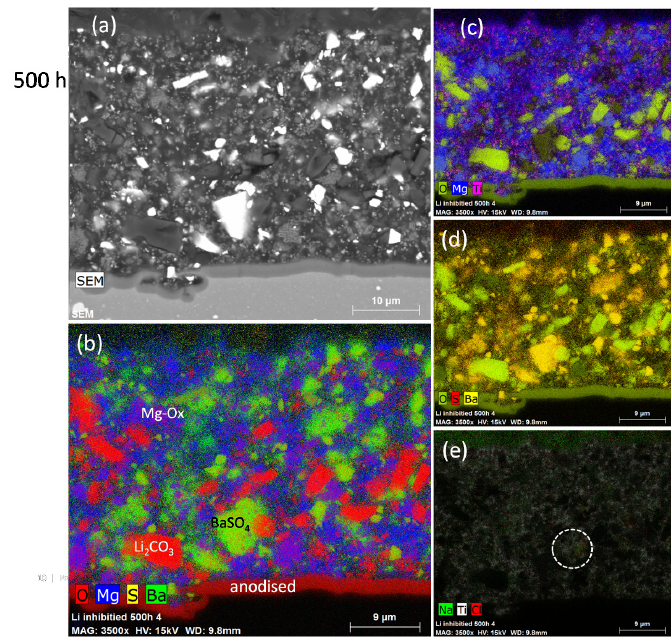
Figure 10. EDS mapping results for sample with 500 h exposure to NSS. ( a ) Backscattered electron image and maps derived from quantitative analysis and composite maps for ( b ) O ‐ Mg ‐ Ba ‐ S with phase labelling ( c ) O ‐ Mg ‐ Ti, ( d ) O ‐ S ‐ Ba and ( e ) Na ‐ Ti ‐ Cl map. (N.B. colour mixing is not the same as three ‐ colour mixing).